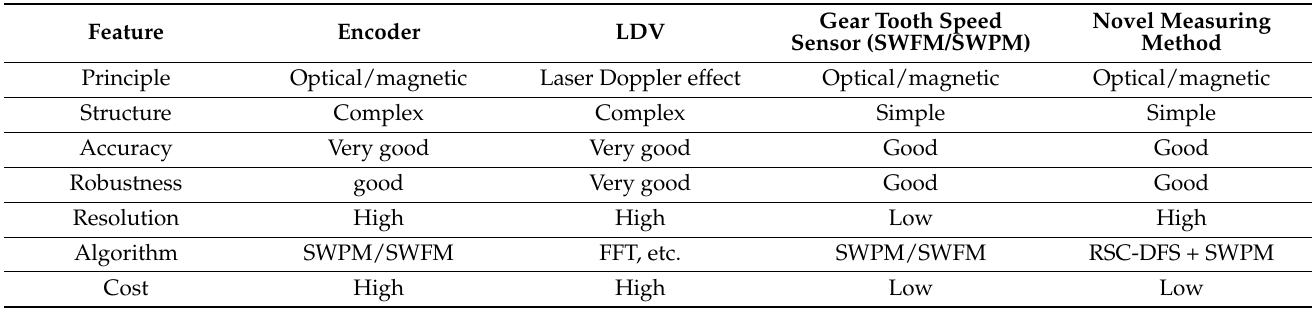
Table 1. Characteristics of different speed measuring